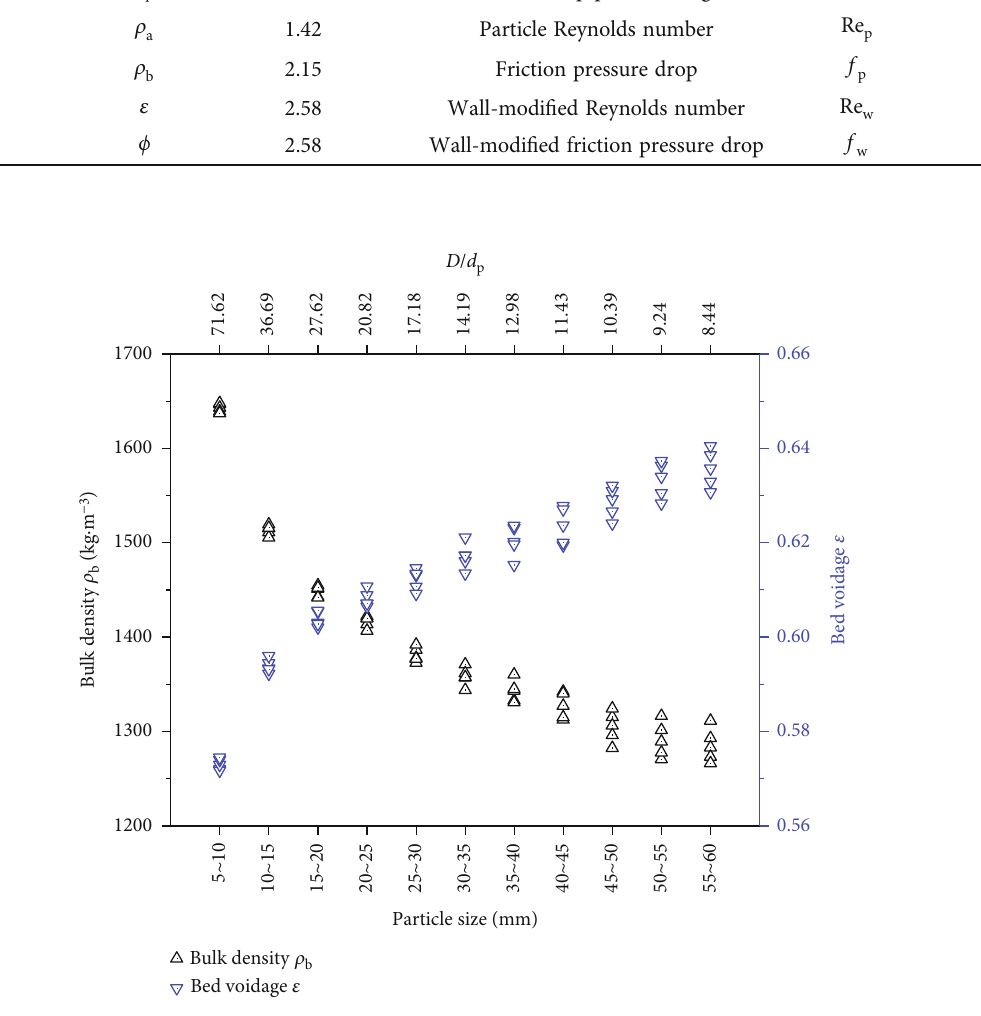
Figure 3: Variation of the bulk density ρ and voidage ε of the sinter bed with the particle size under fi ve repeated experiments. b